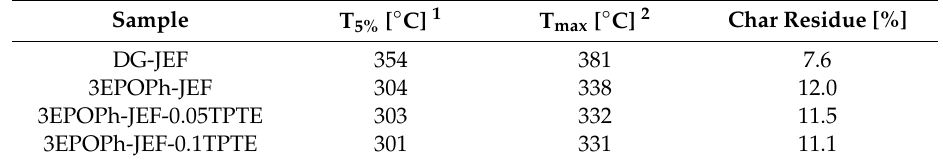
Figure 5. TGA ( a ) and derivative thermogravimetric curves (DTG) ( b ) under N 2 atmosphere at 10 °C/min of the materials studied. Table 3. Thermogravimetric data of the materials prepared.